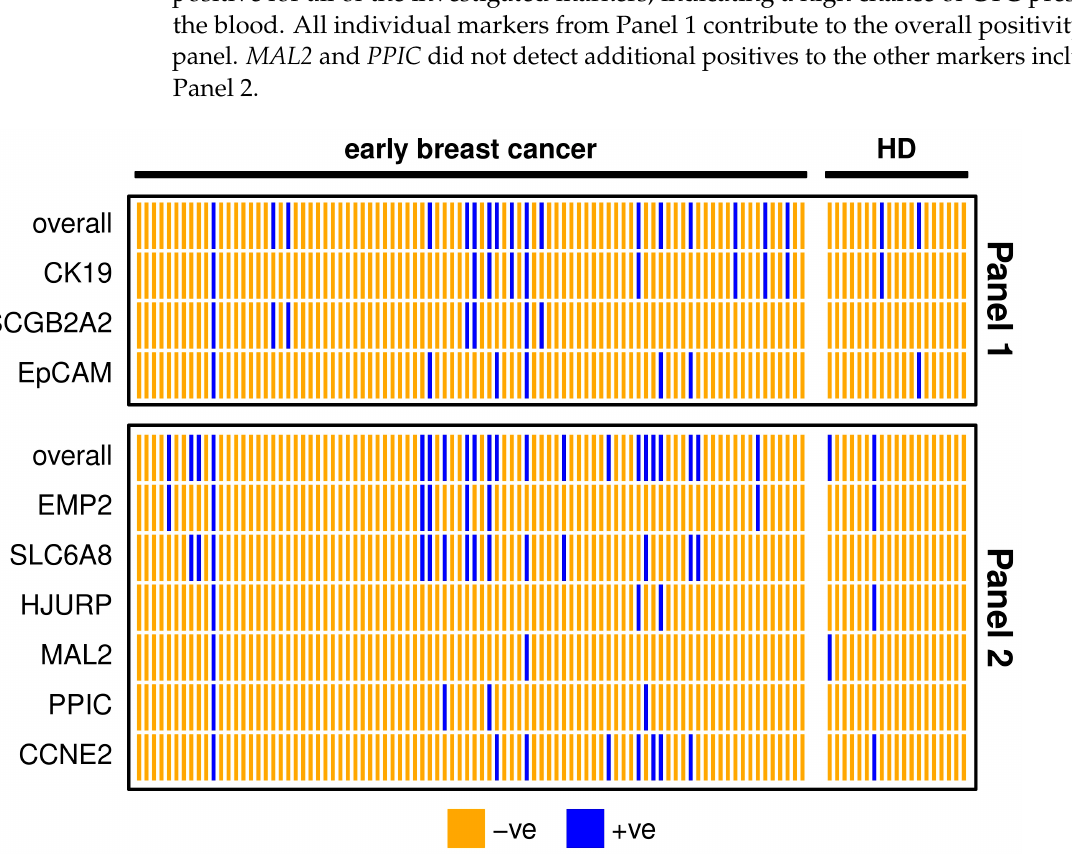
Figure 2. Heatmap showing positive (blue) and negative (orange) early breast cancer patients’ (n = 90) and healthy donor (HD, n = 19) samples for each marker or overall, comparing markers from Panel 1 (upper graph) and Panel 2 (lower graph). For the definition of positivity, a threshold was set considering the gene expression levels in the HD group, in order to allow a maximum of 10% positive findings in the HD